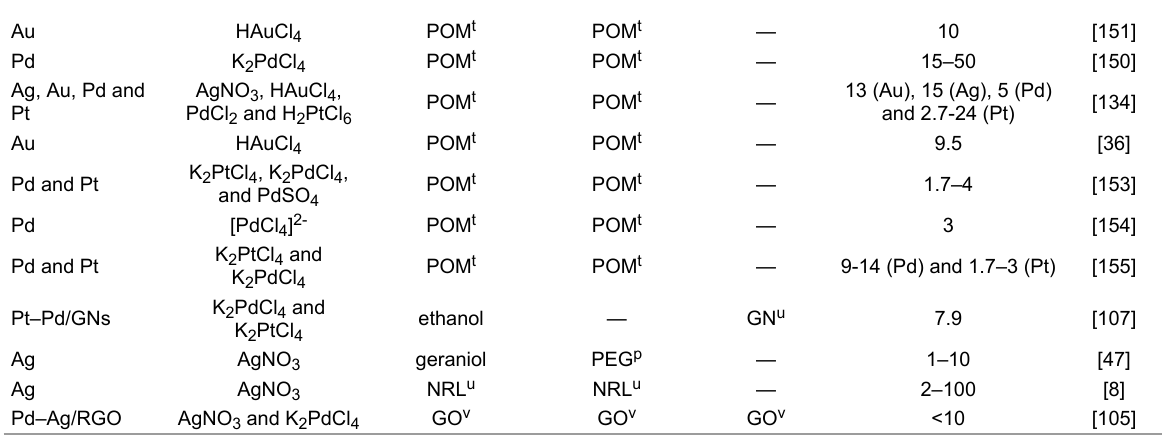
Au Ag, Au, Pd and